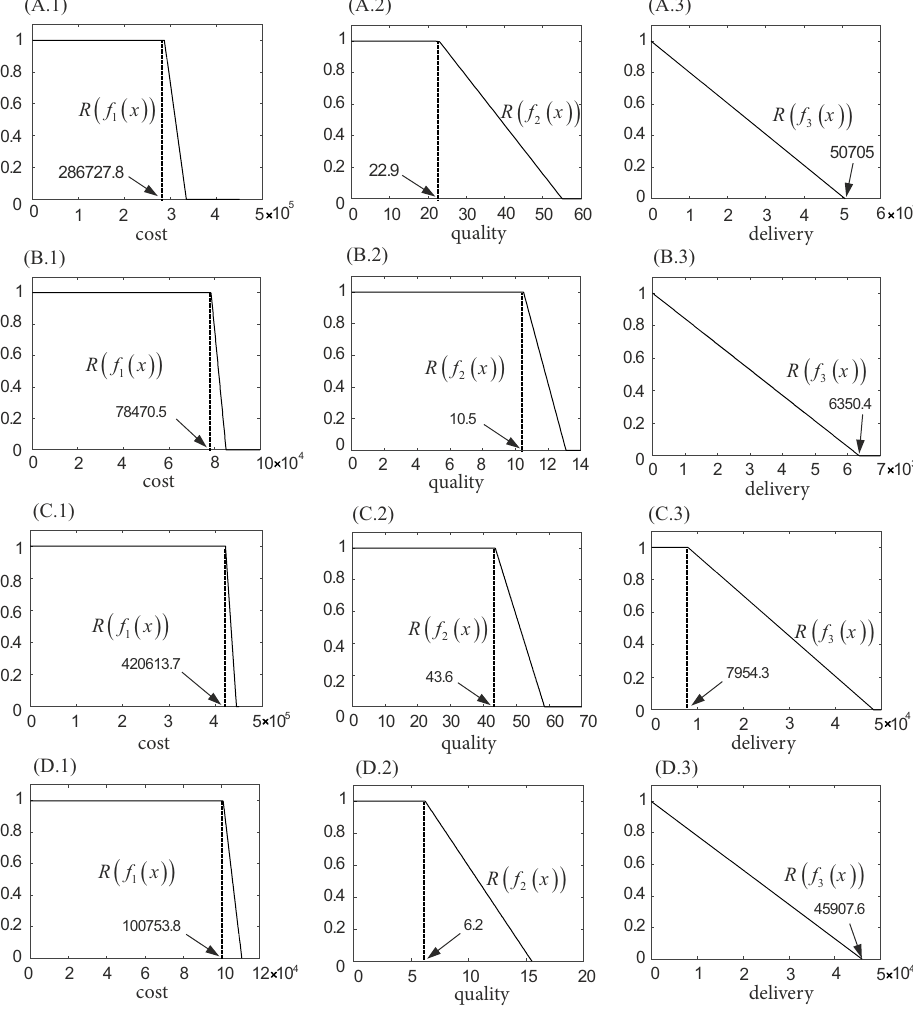
Figure 4. Membership functions of the three objectives: (A.1–A.3): f 1 to f 3 for component A; (B.1–B.3): f 1 to f 3 for component B; (C.1–C.3): f 1 to f 3 for component C; (D.1–D.3): f 1 to f 3 for component